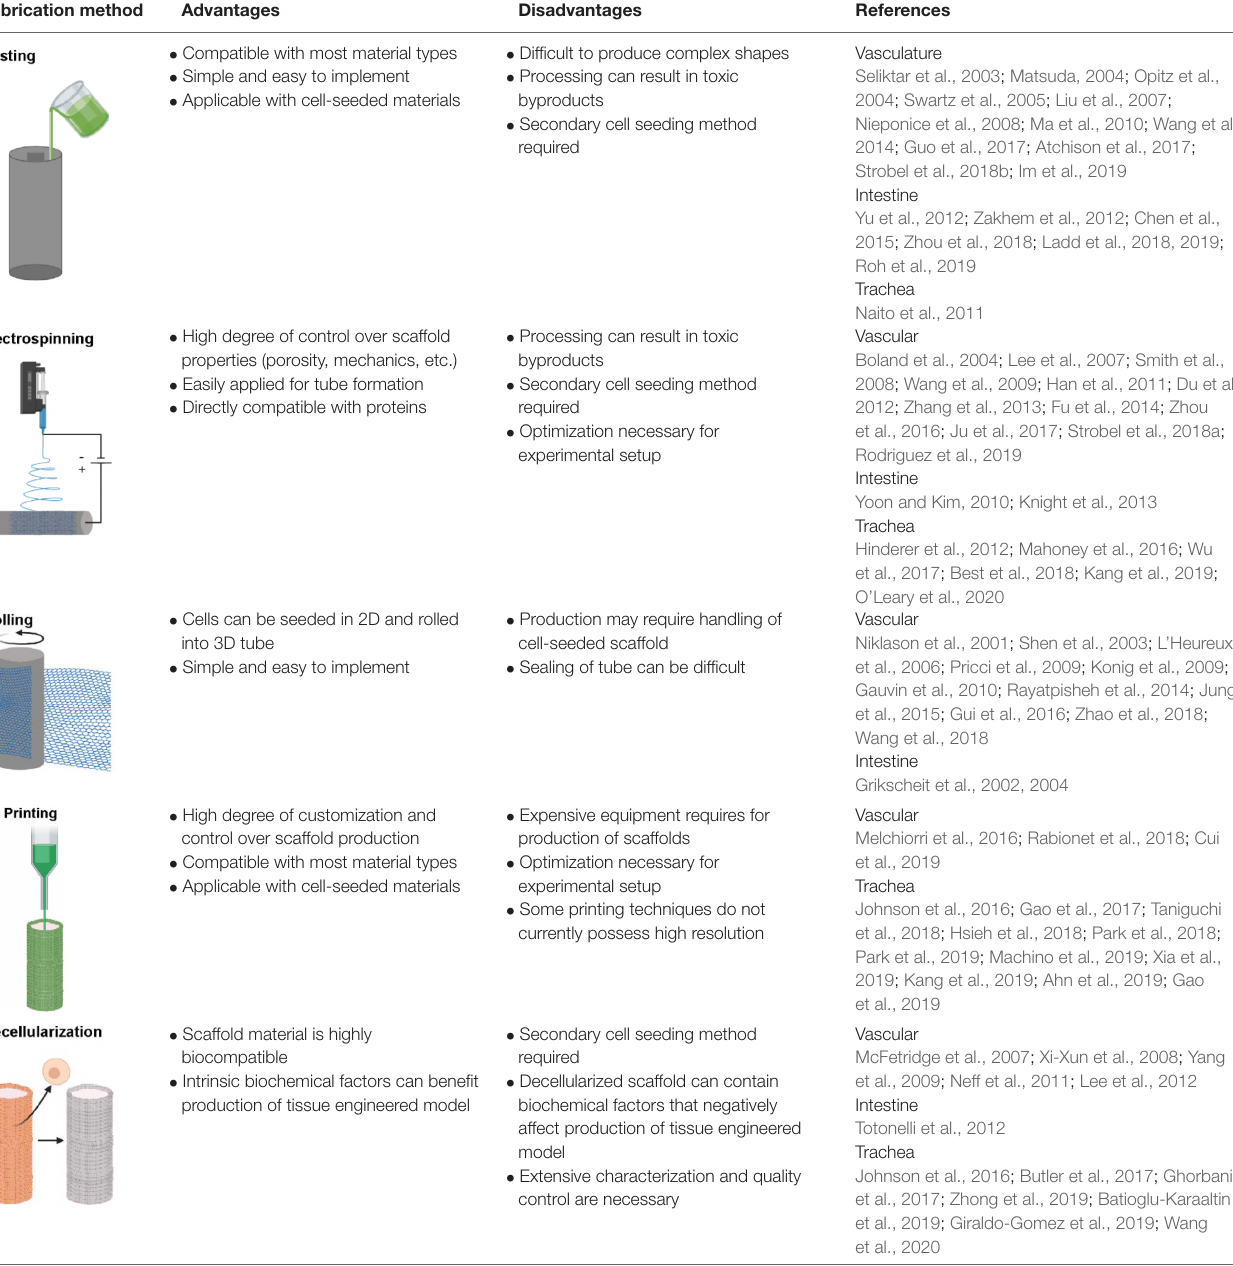
TABLE 3 | Categorization of techniques for manufacturing tubular scaffolds for tissue